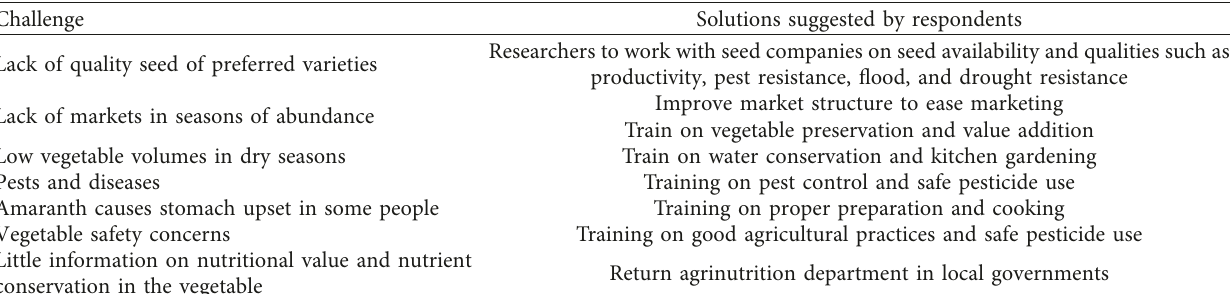
Table 3: Challenges and possible